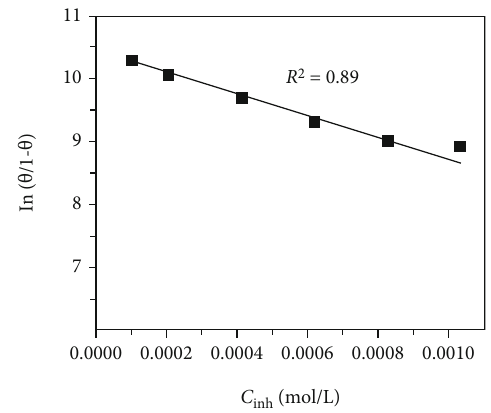
Figure 5: Frumkin type of adsorption isotherm for 1018 carbon steel immersed in 0.5M H complex as corrosion